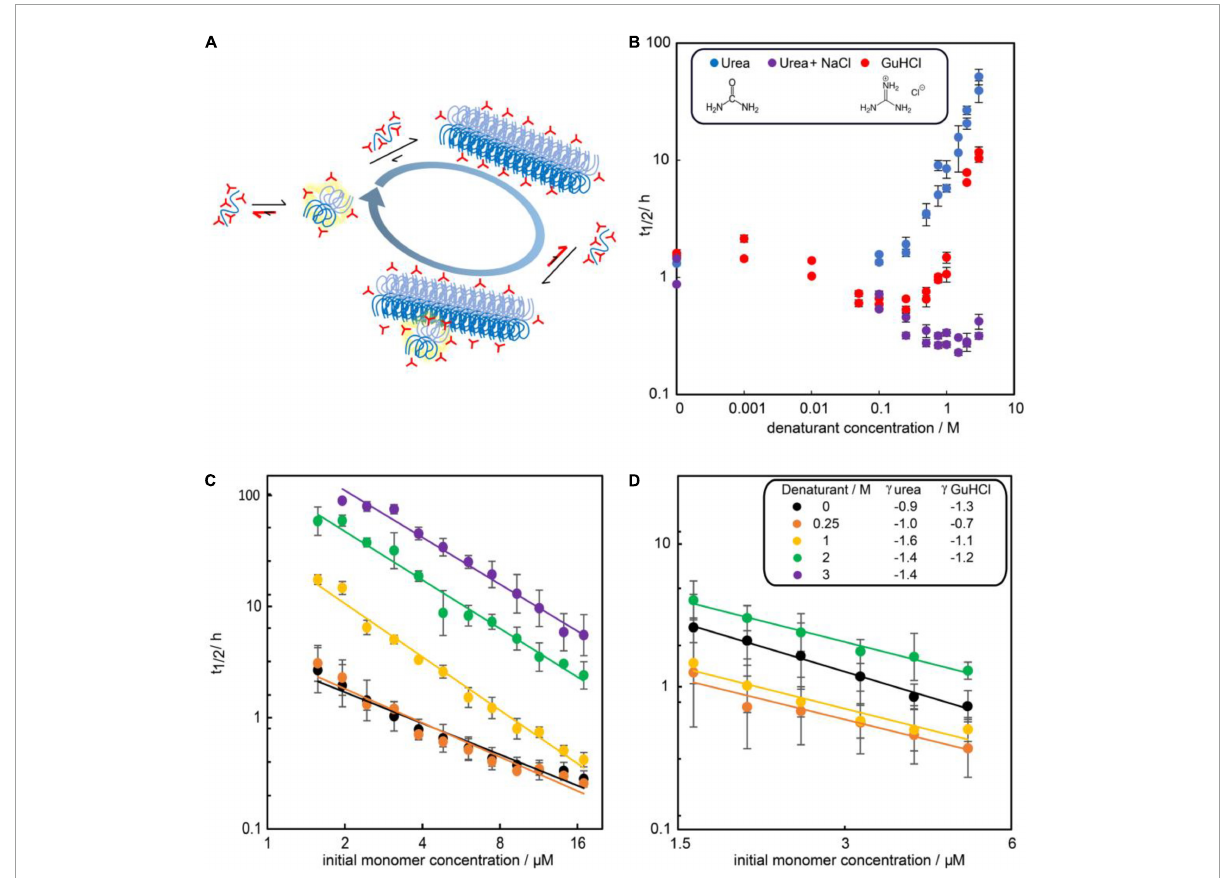
FIGURE3 Influence of denaturants on the aggregation timescale of A β 42. (A) Denaturants (red) favor smaller and less folded species in the reaction network more than large and folded species. (B) Half time of fibril formation versus denaturant concentration for solutions of 3 µ M A β 42 and urea (blue), GuHCl (red) or an equimolar mixture of urea and NaCl (purple) in 20 mM sodium phosphate, 0.2 mM EDTA, 0.02% sodium azide, pH 8.0. (C) Half time of fibril formation as a function of A β 42 monomer concentration in the presence of no (black), 0.25 M urea (orange), 1 M (yellow), 2 M (green), or 3M (purple) urea. (D) Half time of fibril formation as a function of A β 42 monomer concentration in the presence of no (black), 0.25 M (orange), 1 M (yellow), or 2 M (green) GuHCl. Each data point is the average of the log half time over at least two repeats of aggregation experiments with three replicates at each concentration and the error bars represents the standard deviations from all repeats. In panels (C,D) , the scaling exponents were estimated by fitting a power function to the data at each denaturant concentration (Equation